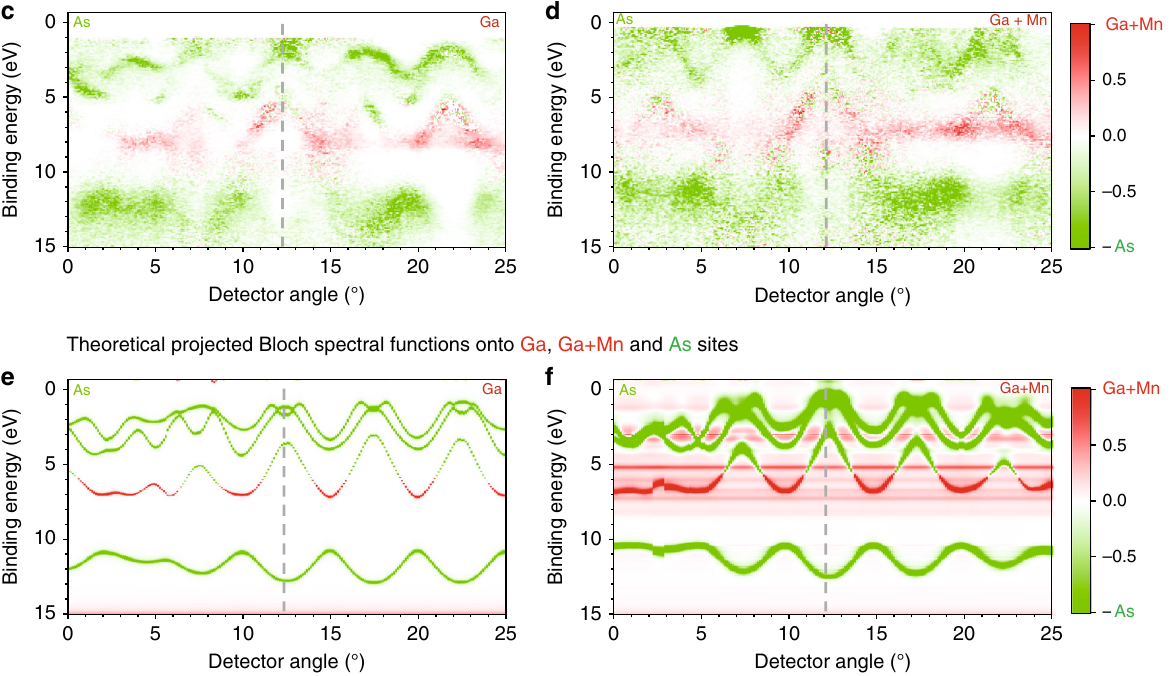
Fig. 4 Experimental hard X-ray angle-resolved photoemission data. Data shown for a GaAs and b (Ga,Mn)As in a (-1-1-1) re fl ection geometry, with photon energy of ∼ 2.7 keV. The light gray curves are calculations based on a local-density band structure excited by direct transitions into free-electron fi nal- states, and were used to determine the precise sampling in k – space, which was slightly different for the two samples. c , d Experimental decomposition into Ga + Mn and As components using core-level intensities and Eqs 1 and 2. The color scale is maximum Ga,Mn = 1.0 and maximum As = − 1.0. e , f theoretical calculations of element-resolved Bloch spectral functions, using the coherent potential approximation for (Ga,Mn)As and the same sampling in k – space as a and